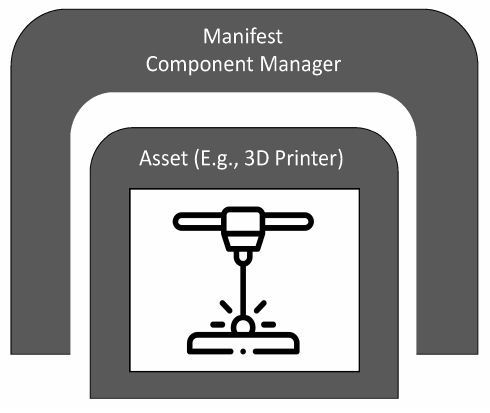
Figure 12. AAS showing an asset (3D